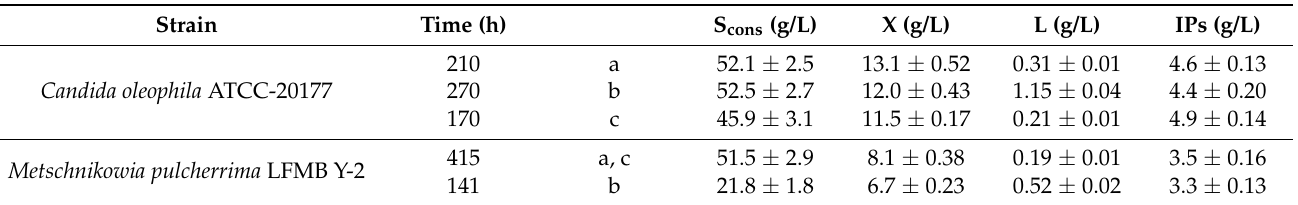
Table 1. Quantitative data of yeast strains that were cultivated on commercial-type xylose (S) under nitrogen-limited conditions in shake-flask